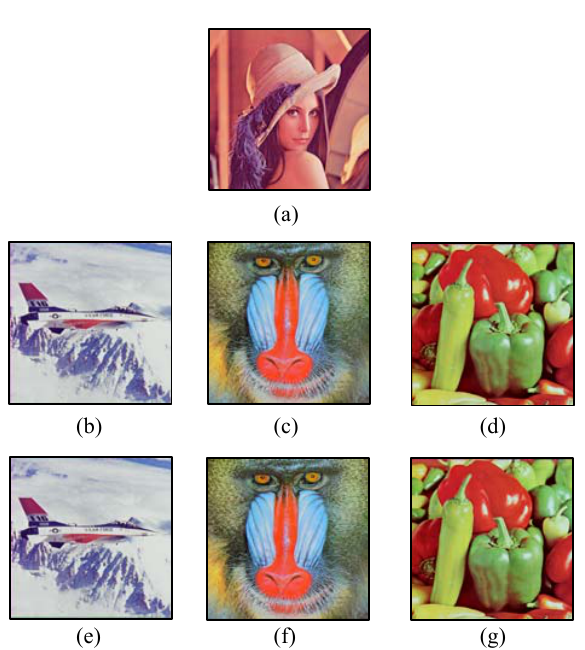
Fig. 8. (2, 3)-threshold color secret image sharing. (a) The secret image S (256  256), (b) Camouflage image Jet, (c) Camouflage image Baboon, (d) Camouflage image Pepper, (e) stego-image PSNR= 44.58 dB, (f) stego-image PSNR=44.61 dB, (g) stego-image PSNR=44.54 dB.